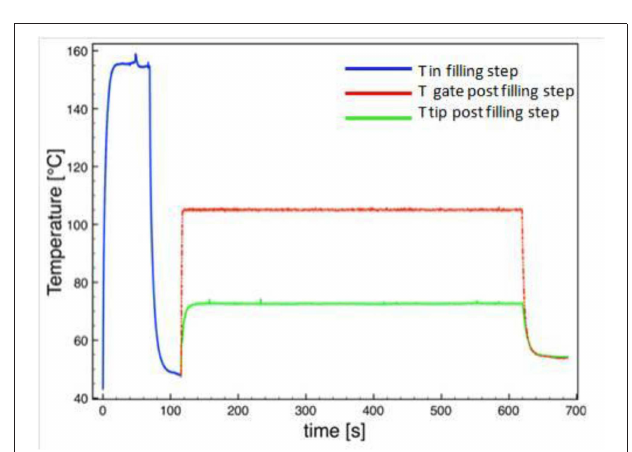
FIGURE 3 | Temperature measurements during the